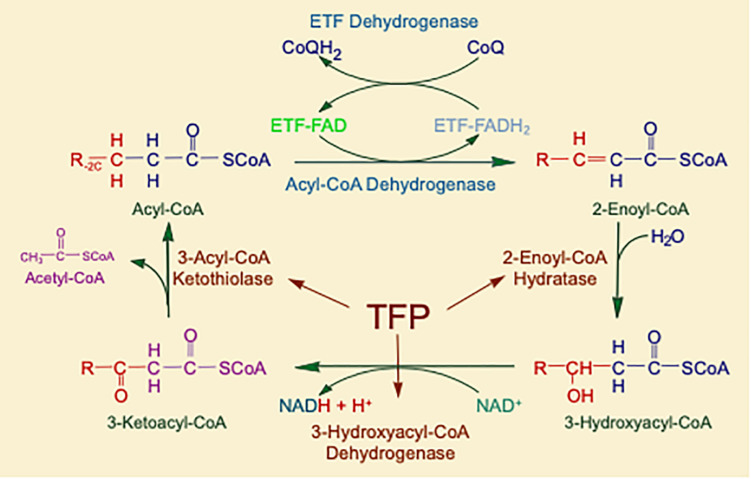
The matrix reactions of FAO consist of four steps that result in one molecule of acetyl-CoA and an acyl-CoA that is shortened by two-carbon units. For long-chain substrates, VLCAD, which catalyzes the first step is long-chain fatty acid β-oxidation, is the most important acyl-CoA dehydrogenase for energy generation. The next three steps are performed by a single multifunctional enzyme with three active sites, the mitochondrial TFP. All abbreviations are as defined in the text.